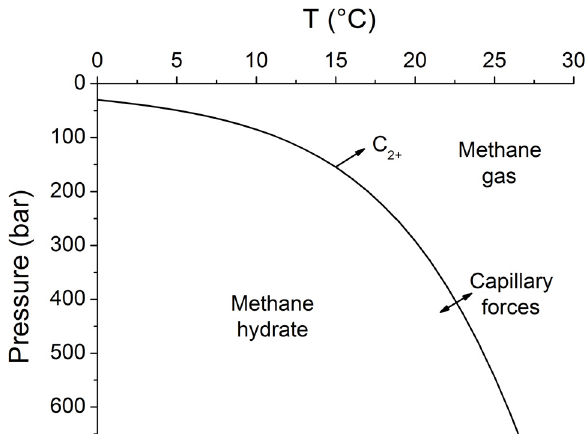
Figure 7. Phase diagram for methane hydrate (structure type I) for sulfate-free seawater with a salinity of 35 [34]. Arrows indicate the formation of a transition zone by capillary forces and the broadening of the gas hydrate stability zone by higher hydrocarbon compounds (C 2+